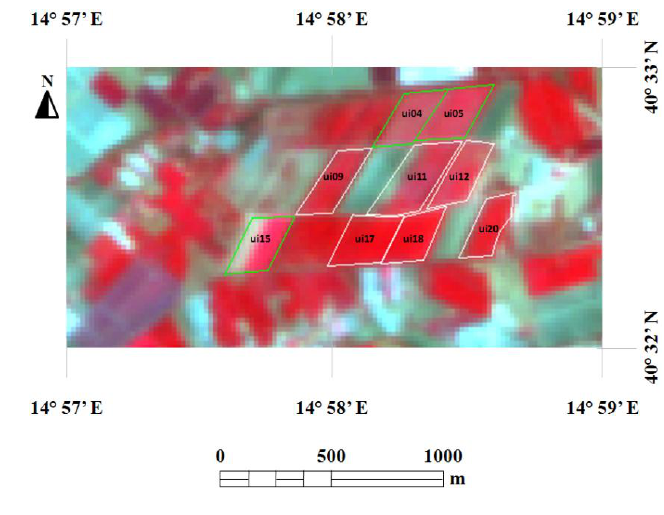
Figure 2. CIR DEIMOS image of the Improsta farm (9 August) showing boundaries of the “irrigated units” ( u.i. ): corn (white bounded) and alfalfa (green